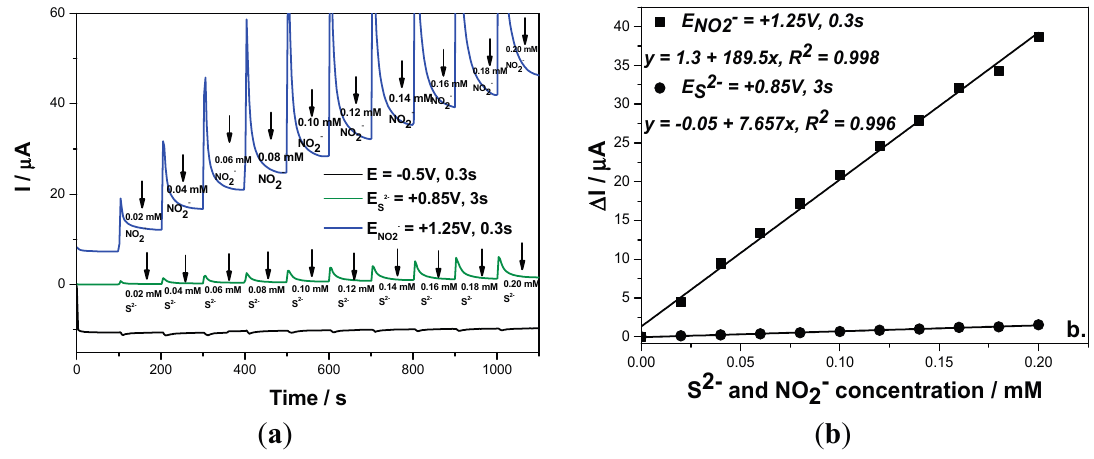
Figure 7. ( a ) Multiple-pulsed amperograms recorded at a BDD electrode in 0.1 M Na 2 SO 4 supporting electrolyte and adding continuously a mixture of 0.02 mM NO 2 − and 0.02 mM S 2 − , recorded at E 1 = − 0.5 V/SCE, E 2 = +0.85 V/SCE, E 3 = +1.25 V/SCE; ( b ) Calibration plot of the current vs . anion concentration recorded at: E 2 = +0.85 V/SCE vs . sulfide concentration and E 3 = +1.3 V/SCE vs . nitrite concentration. Table 2. The electroanalytical parameters of simultaneous detection of voltammetric/ amperometric detection of sulfide and nitrite at a BDD electrode using different techniques. Tehnique